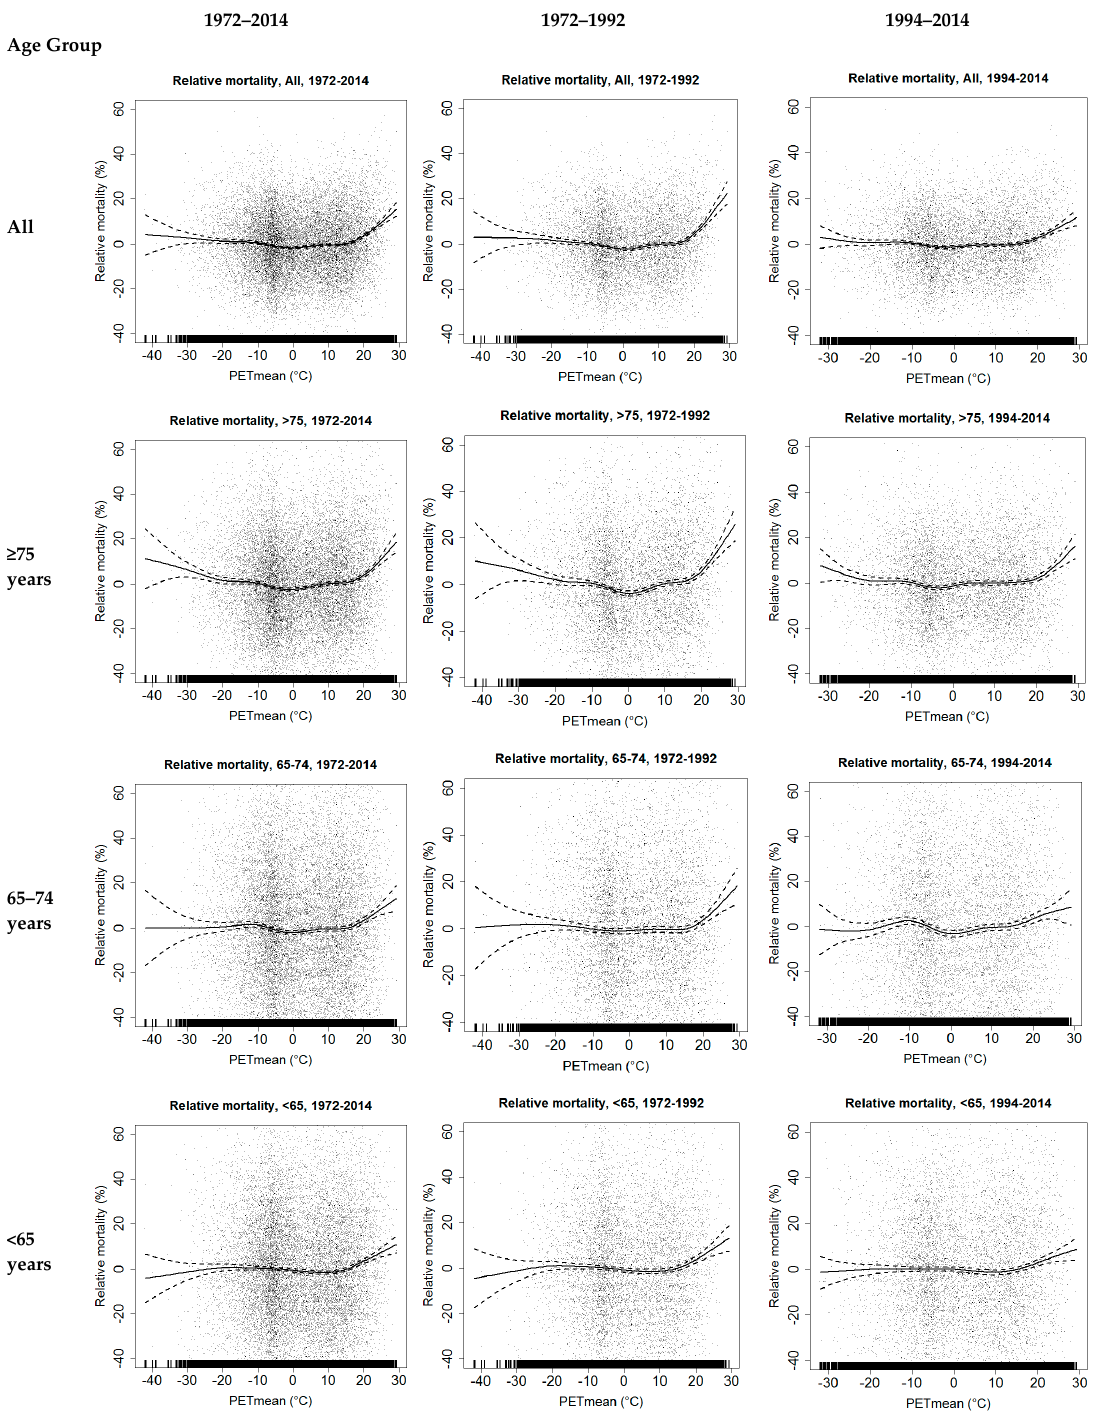
Figure 2. Scatterplots of relative mortality in different age groups and the daily mean value of physiologically equivalent temperature (PET) in the Helsinki-Vantaa weather station in the period of 1972–2014 and in two 21-year time periods, 1972–1992 and 1994–2014. Generalized additive models (GAM) fitted to the data (solid curves) with 95% confidence intervals (dashed curves).